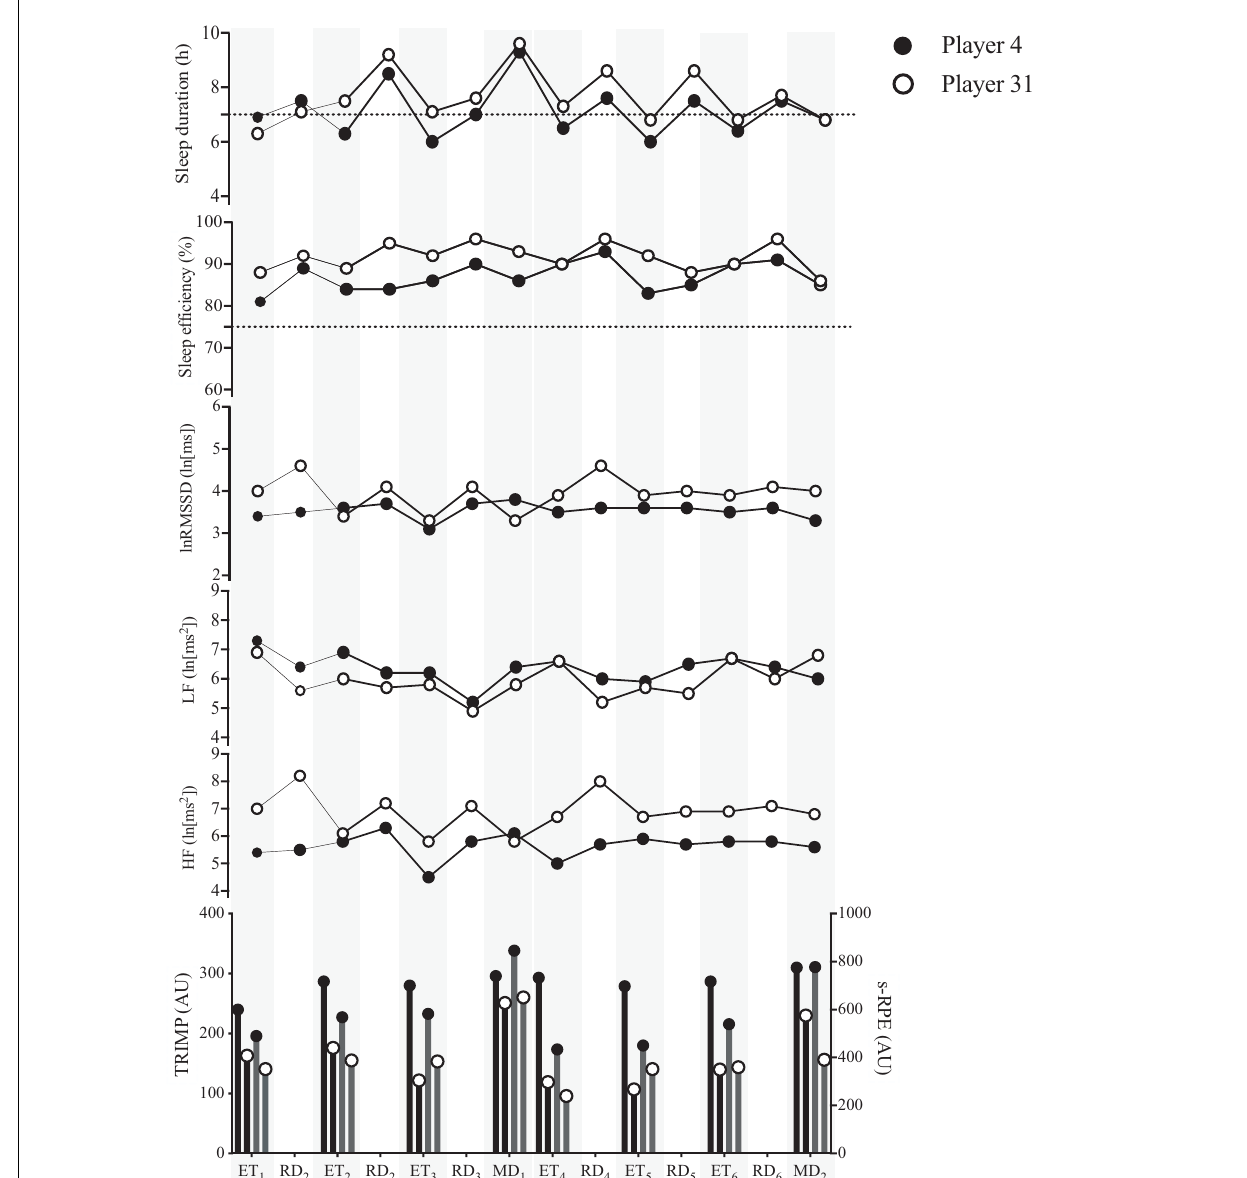
FIGURE 3 | Sleep and nocturnal HRV indices of two players, that played on both match-days (MD), with the smallest (player 31) and highest (player 4) values of training impulse (TRIMP) and session-rating of perceived exertion (s-RPE), accumulated during the 14 days. The black line dashes represent sleep duration and sleep efficiency recommended amounts (i.e., sleep duration < 7 h and sleep efficiency < 75%), respectively. Black and gray bars represent accumulated TRIMP and s-RPE, respectively. Shaded areas denote ET and MD. ET, evening-time training sessions; RD, rest-days; lnRMSSD, logarithm of the root mean square of successive R-R intervals; lnLF, natural logarithm of low frequency; lnHF, natural logarithm of high frequency; AU, arbitrary